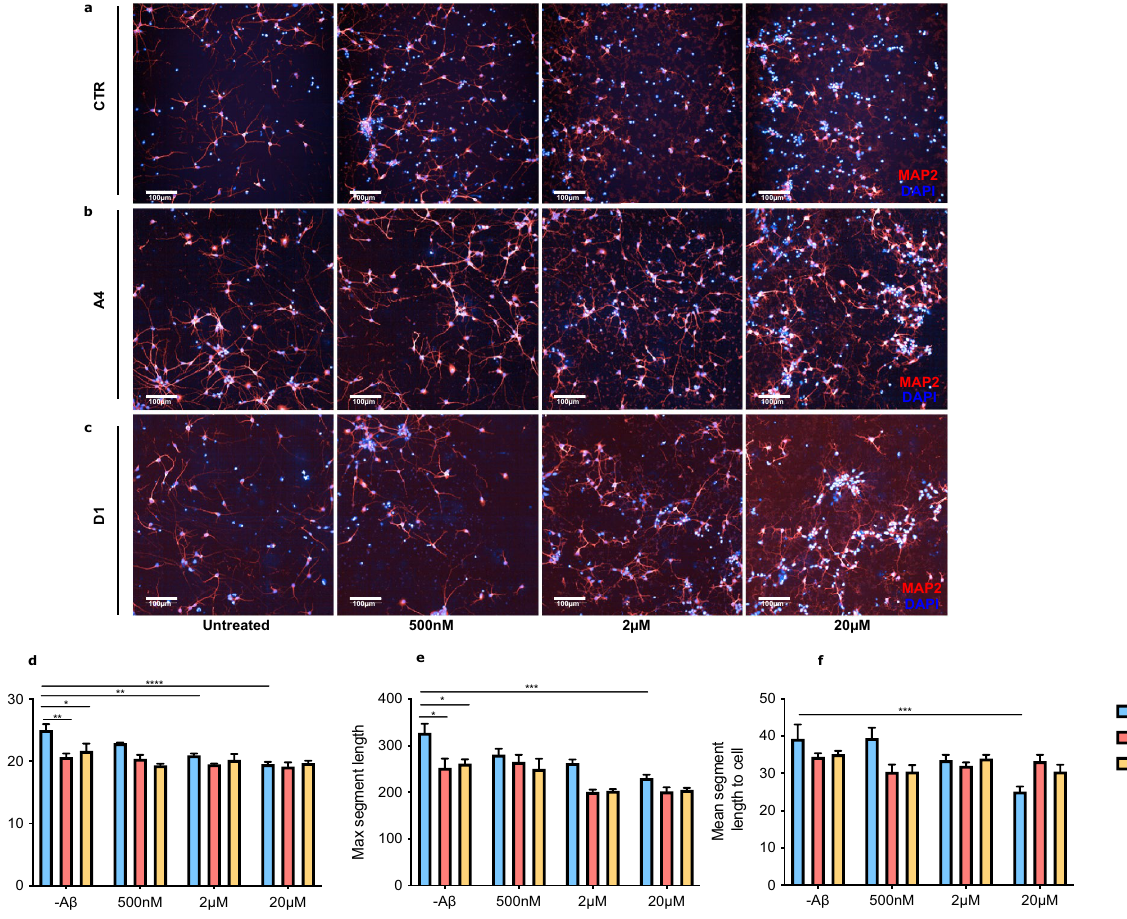
Figure 3. Aβ 25–35 does not induce neurite retraction in exon 2 −/− neurons. CTR and exon 2 −/− (A4 and D1) neurons were treated for 24 h with one of three concentrations of Aβ 25–35 . Following treatment, neurons were fixed, immunostained for DAPI (blue) and MAP2 (red) and imaged. Representative images of ( a ) CTR, ( b ) A4 and ( c ) D1 neurons. ( d – f ) Changes in length of neuronal processes were then quantified using an automated analysis software pipeline that identified MAP2 positive areas. Before treatment, mean segment length (CTR vs A4: p = 0.0310** and CTR vs D1: p = 0.0379*) and maximum segment length were significantly reduced in exon 2 −/− neurons than CTR neurons (CTR vs A4: p = 0.0161* and CTR vs D1: p = 0.0487*). 20 μM Aβ 25–35 induced significant reductions in neurite length parameters in CTR neurons but not in exon 2 −/− neurons (CTR: mean segment length; p < 0.0001****, maximum segment length; p = 0.0009***, mean segment length to cell; p = 0.0010***). Exon 2 −/− neurons did not display evidence of Aβ 25–35 induced neurite damage at any concentration of Aβ 25–35 . Values are reported as mean ± SEM and Two-Way ANOVAs were performed for all time points (*p < 0.05, **p < 0.01, ***p < 0.001 and ****p < 0.0001). Mean values were calculated from samples collected from three independent differentiations of neurons (n = 3), of which each contained 6 replicant